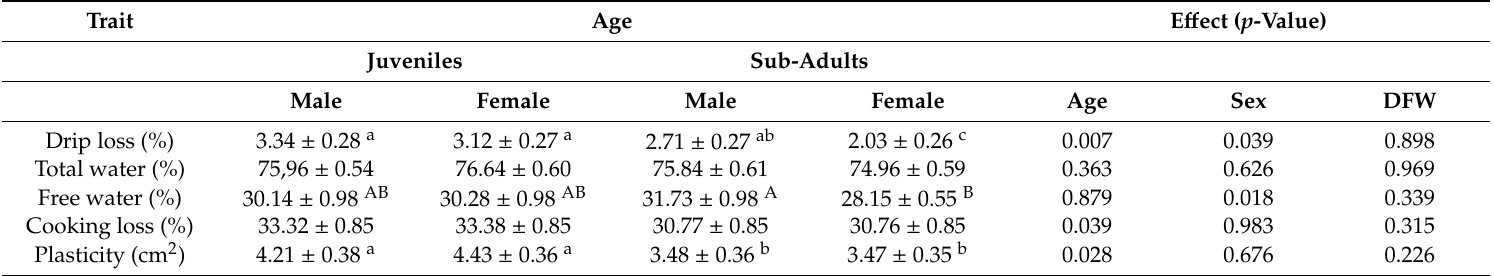
Table 5. The capacity to hold residual water, water fractions and plasticity of m. semimembranosus from the wild boar (mean ±